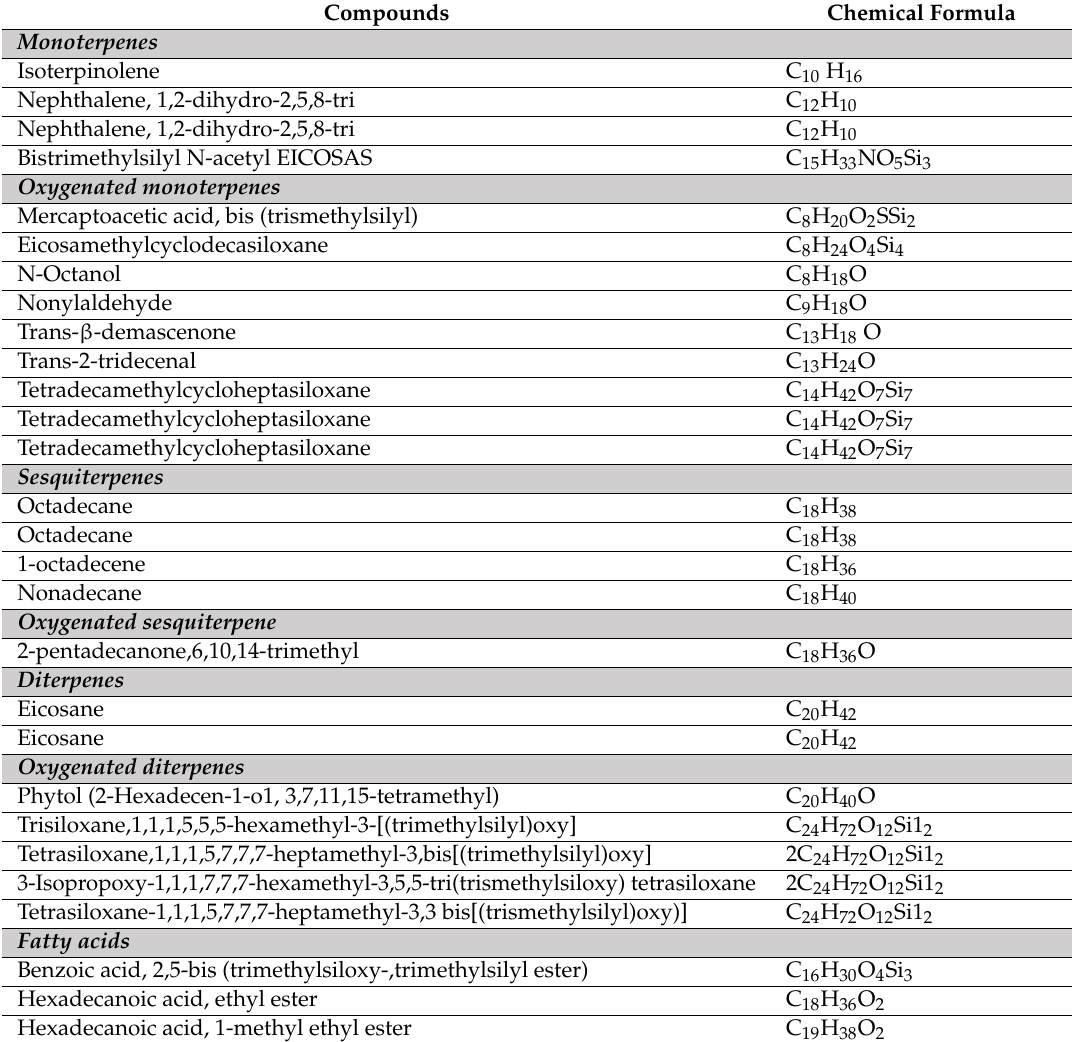
Table 3. List of the molecules present in the essential oils of the leaves of Carpobrotus edulis [46]. Compounds Chemical Formula Monoterpenes